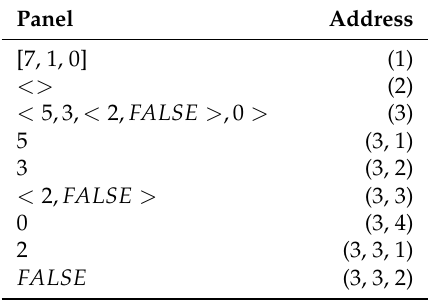
Table 1. Addresses of plenix of